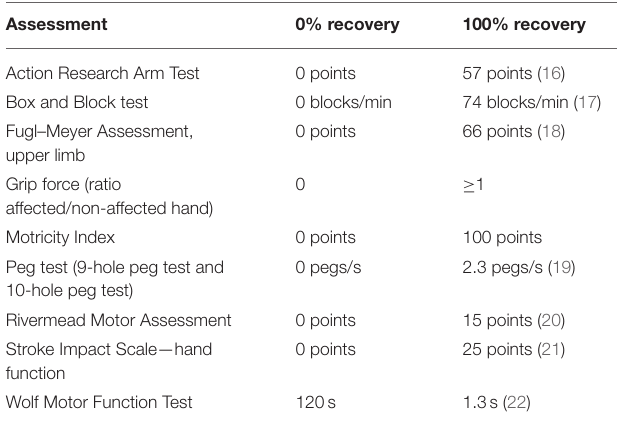
TABLE 1 | Rescaling of assessments to their respective percentage of